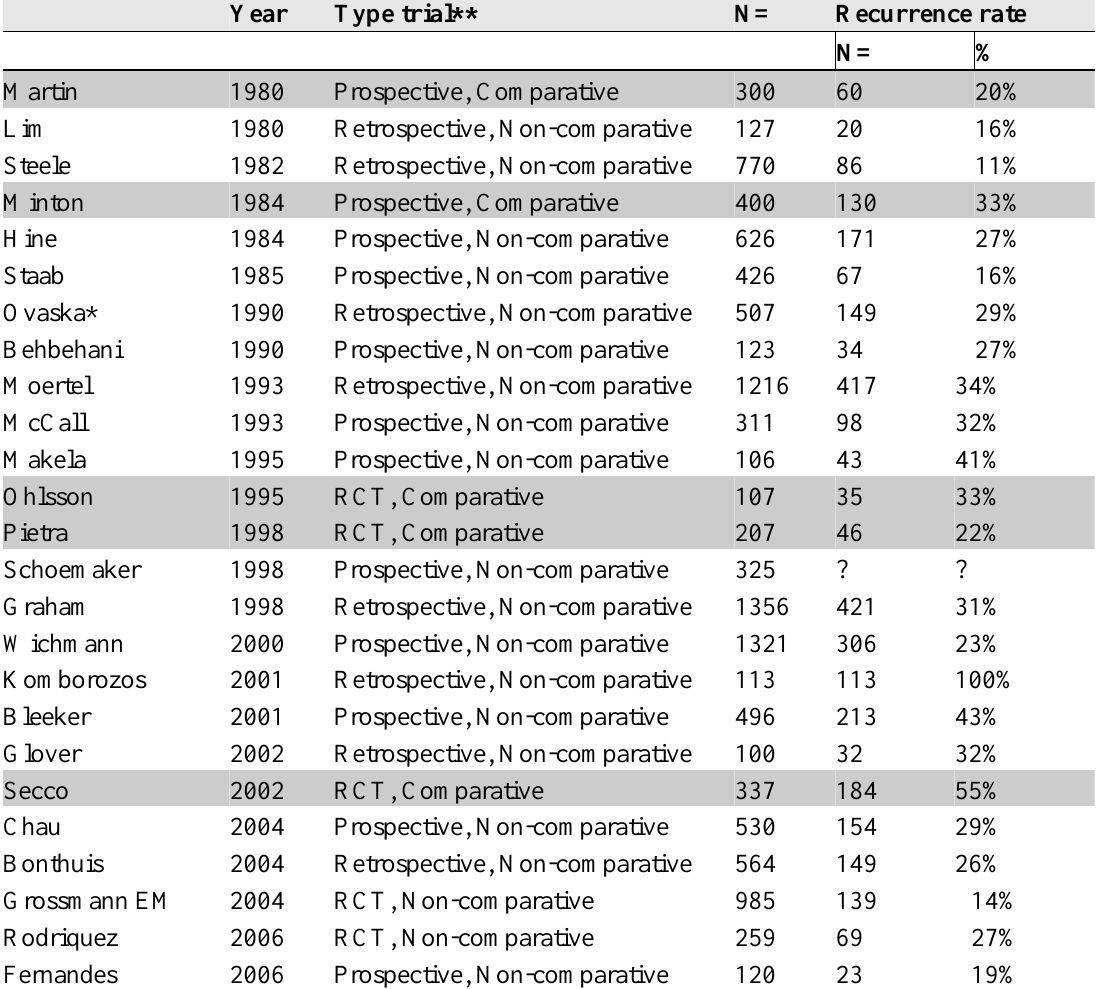
Table 1. Clinical studies on follow-up including CEA measurements (n =